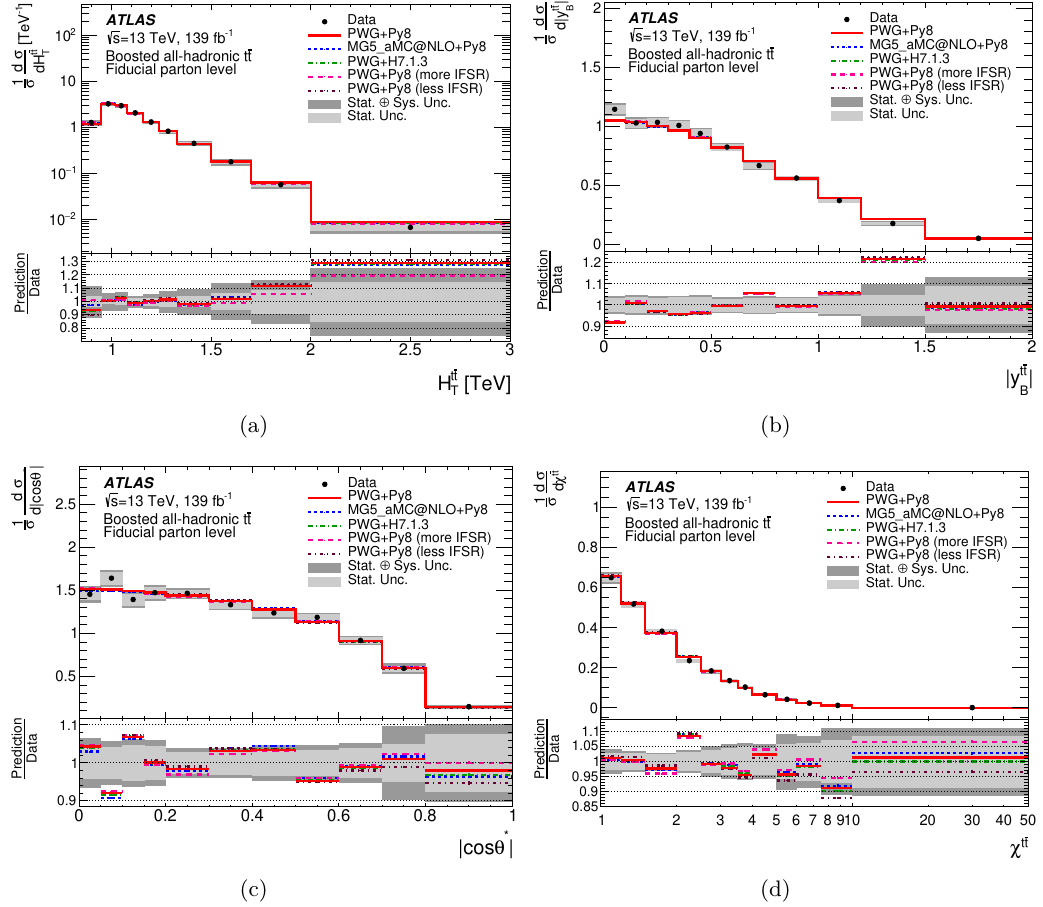
Figure 45 . Normalized parton-level fiducial phase-space differential cross-sections as a function of (a) the scalar sum of the transverse momenta of the top quarks, (b) the rapidity boost, (c) the production angle in the Collins–Soper reference frame, and (d) the production angle χ t ¯ t . The dark and light grey bands indicate the total uncertainty and the statistical uncertainty, respectively, of the data in each bin. Data points are placed at the centre of each bin. The Powheg+Pythia 8 MC sample is used as the nominal prediction to correct the data to parton